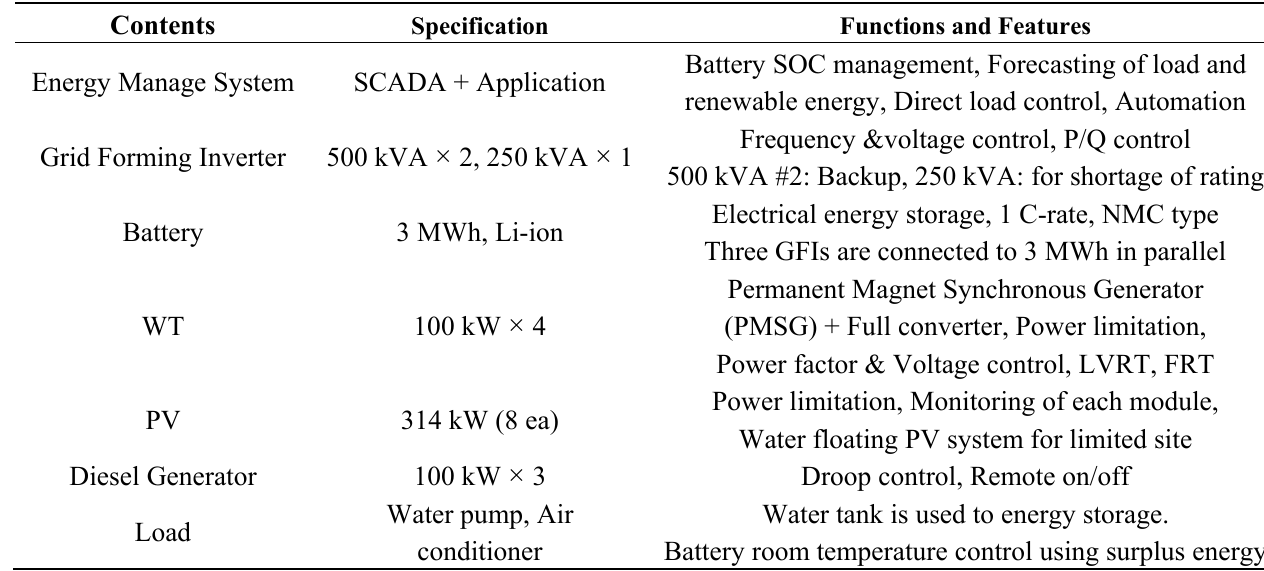
Table 6. Functions and Features of Installed